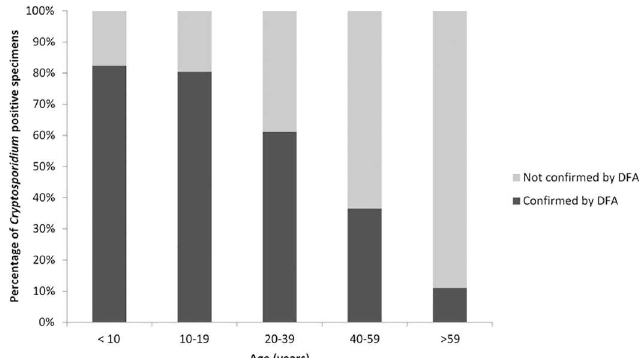
Fig 2. Age distribution of persons for which stool specimens tested positive for Cryptosporidium infection by Meridian ImmunoCard Stat! rapid cartridge assay at community laboratories, by DFA